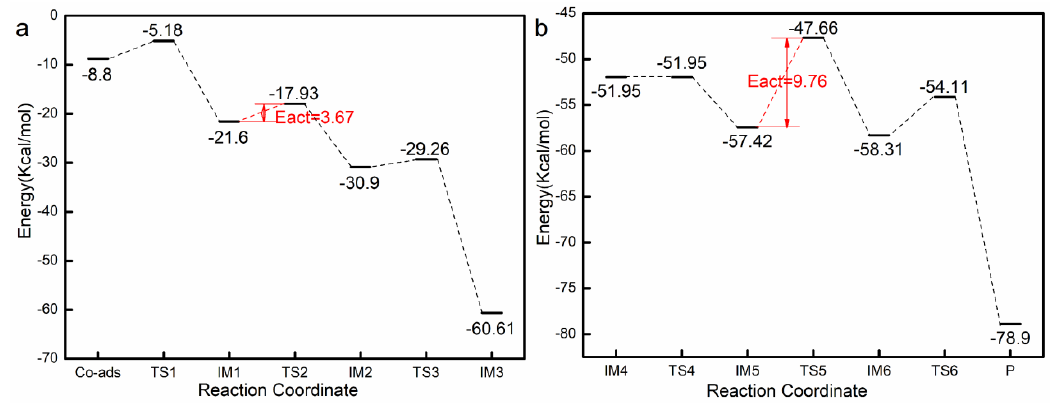
Figure 5. The energy diagrams of acetylene hydrogenation catalyzed by S-doped C site.